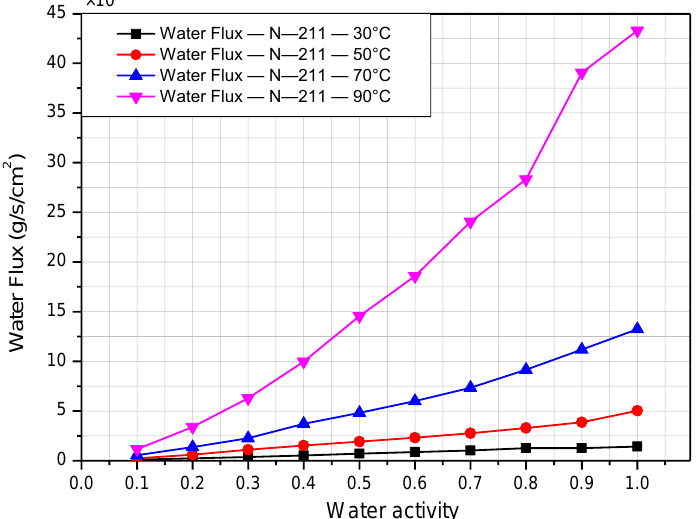
Figure 9. Nafion 211 membrane water flux according to relative humidity at operating temperatures from 30 °C to 90 °C.